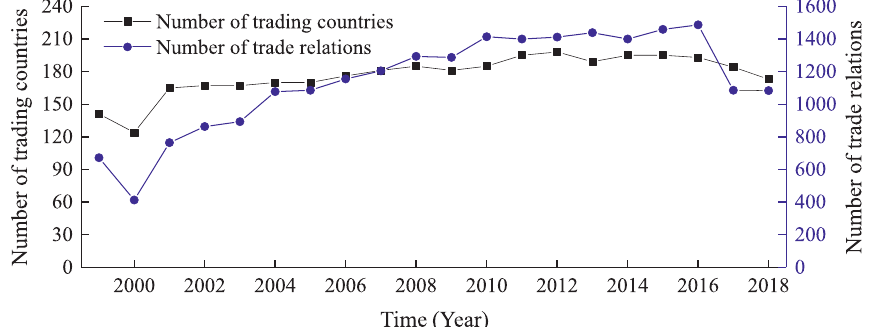
Figure 3. Trends in the total international trade of